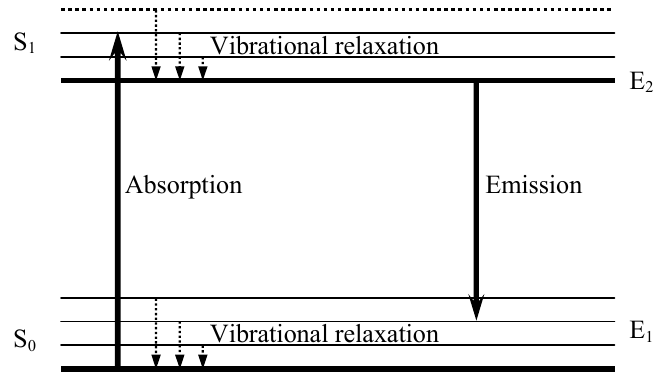
Figure 1. Energy levels responsible for photon absorptions and emissions in organic dyes.